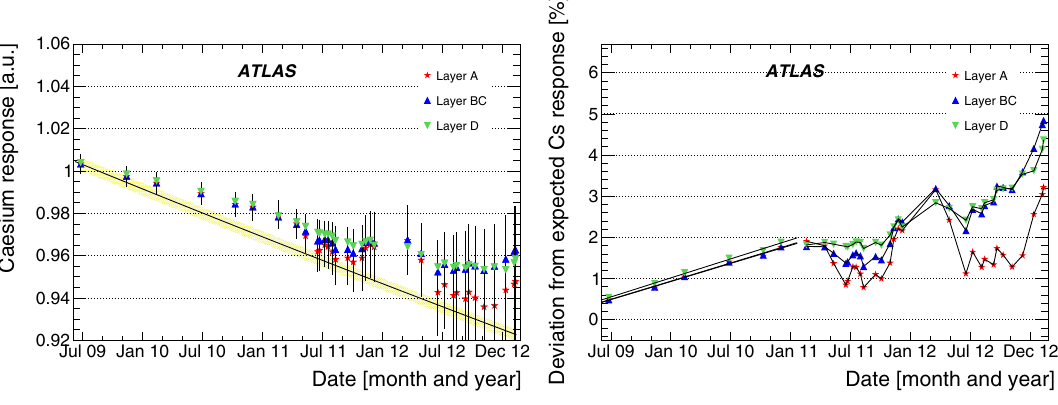
Fig. 14 The plot on the left shows the average response (in arbitrary units, a.u.) from all cells within a given layer to the 137 Cs source as a function of time from July 2009 to December 2012. The solid line rep- resents the expected response, where the Cs source activity decreases in time by − 2 . 3%/year. The coloured band shows the declared preci- sion of the Cs calibration ( ± 0 . 3%). The plot on the right shows the percentage difference of the response from the expectation as a func-